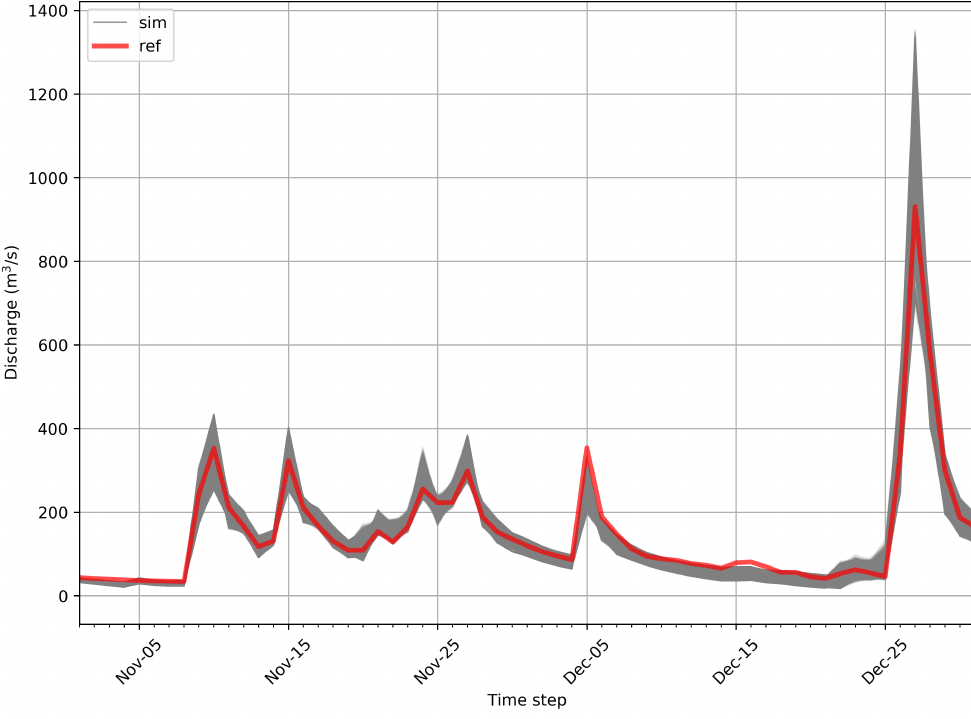
Figure 13. Observed (red) and calculated (gray) discharges for November and December 1882 using the 100 precipitation realizations and 441 different parameter